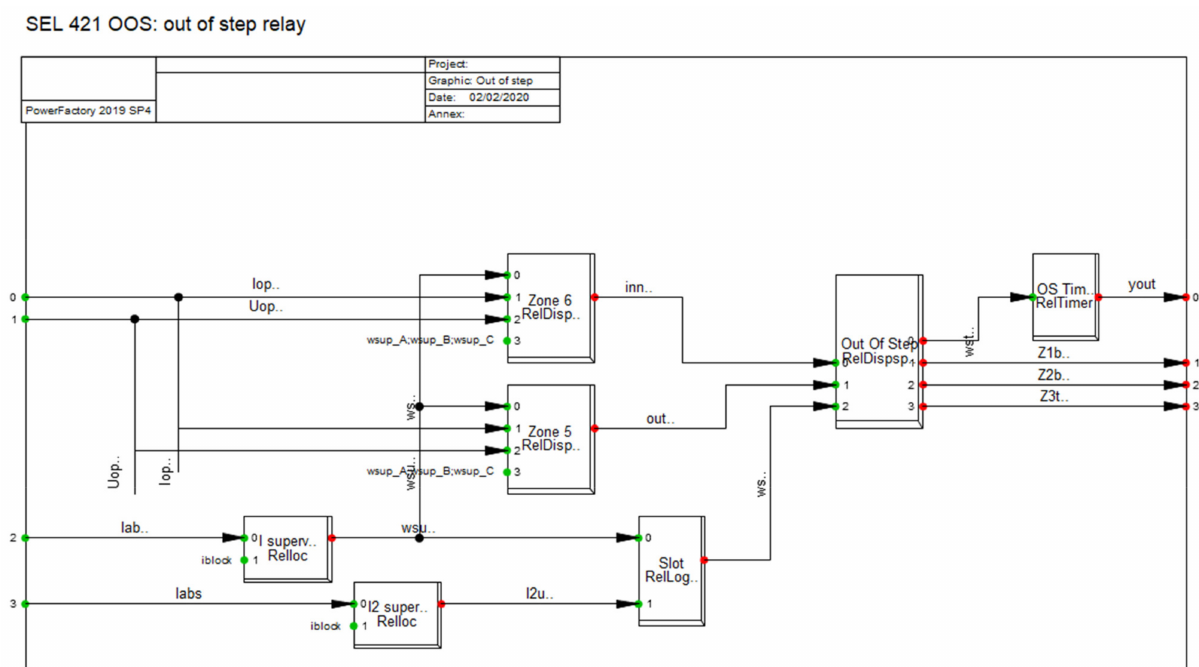
Figure 13. Block diagram of PowerFactory model of OOS function implementation of SEL-421.